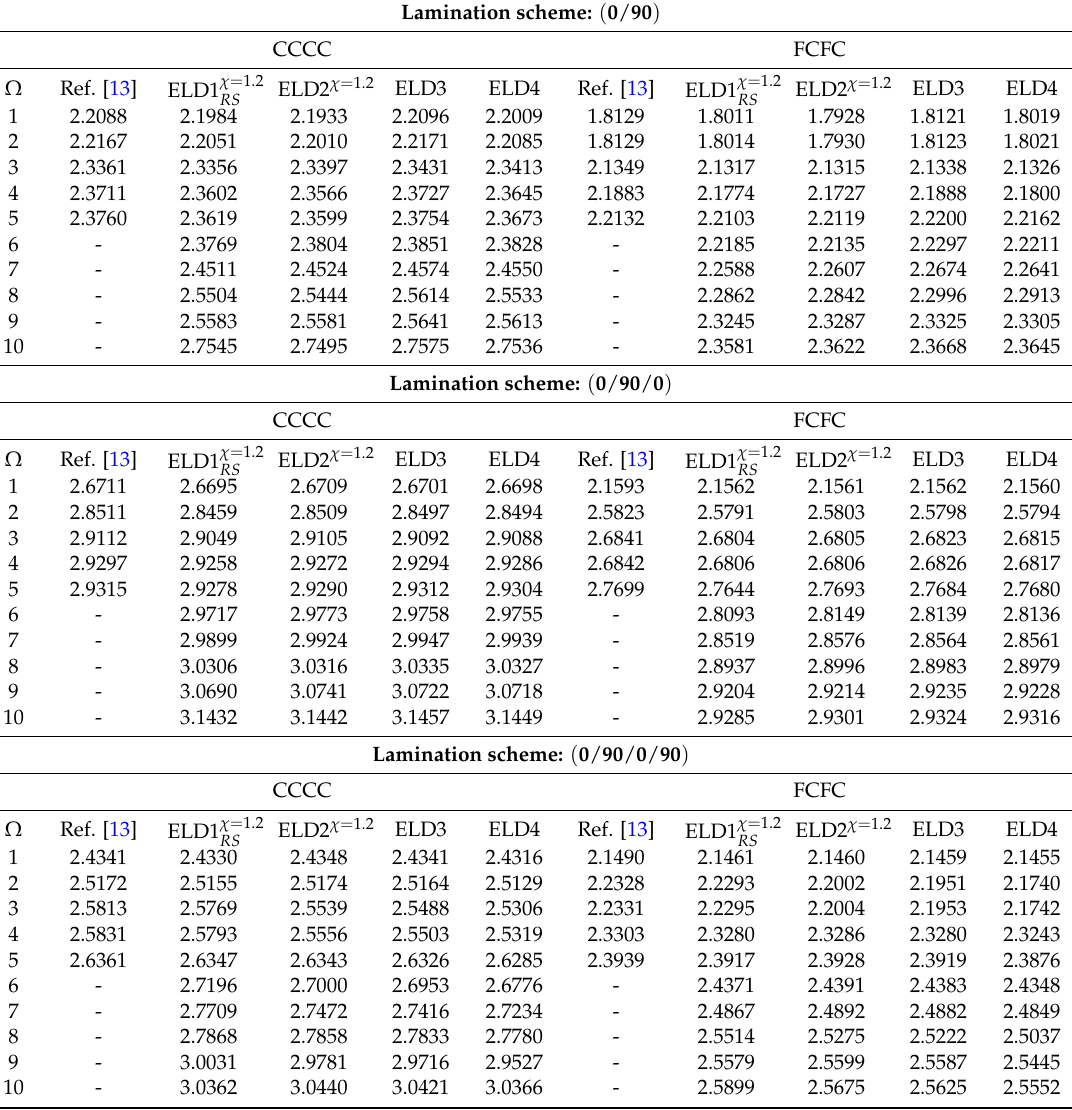
Table 5. Comparison of the frequency parameter Ω = 2 π f R toro-circular panel ( R b = 1.5m) with different boundary conditions and lamination schemes. The ELW solutions are obtained by means of the GDQ method, using the Cheb-Gau-Lob grid distribution and assuming I N = 21 and I M =